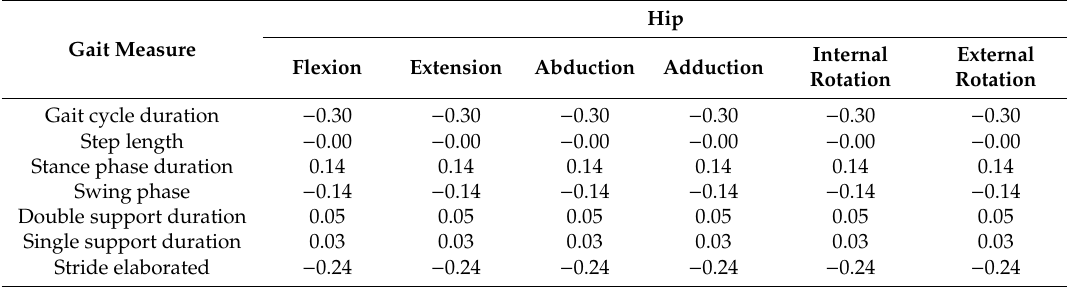
Table 4. Correlation between the lower-limb hip muscles in the MMT and the gait variables of hemiplegic stroke patient’s a ff ected